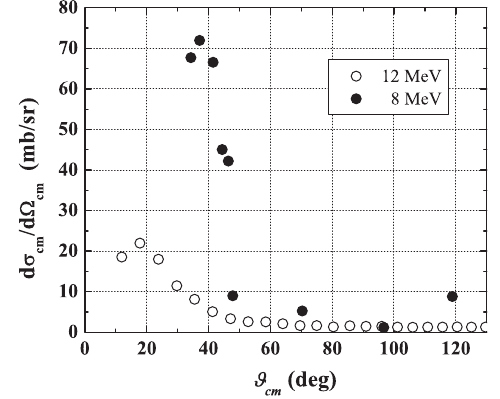
FIG. 25. Center of mass angular distribution for the protons corresponding to 8 Li in the ground state.